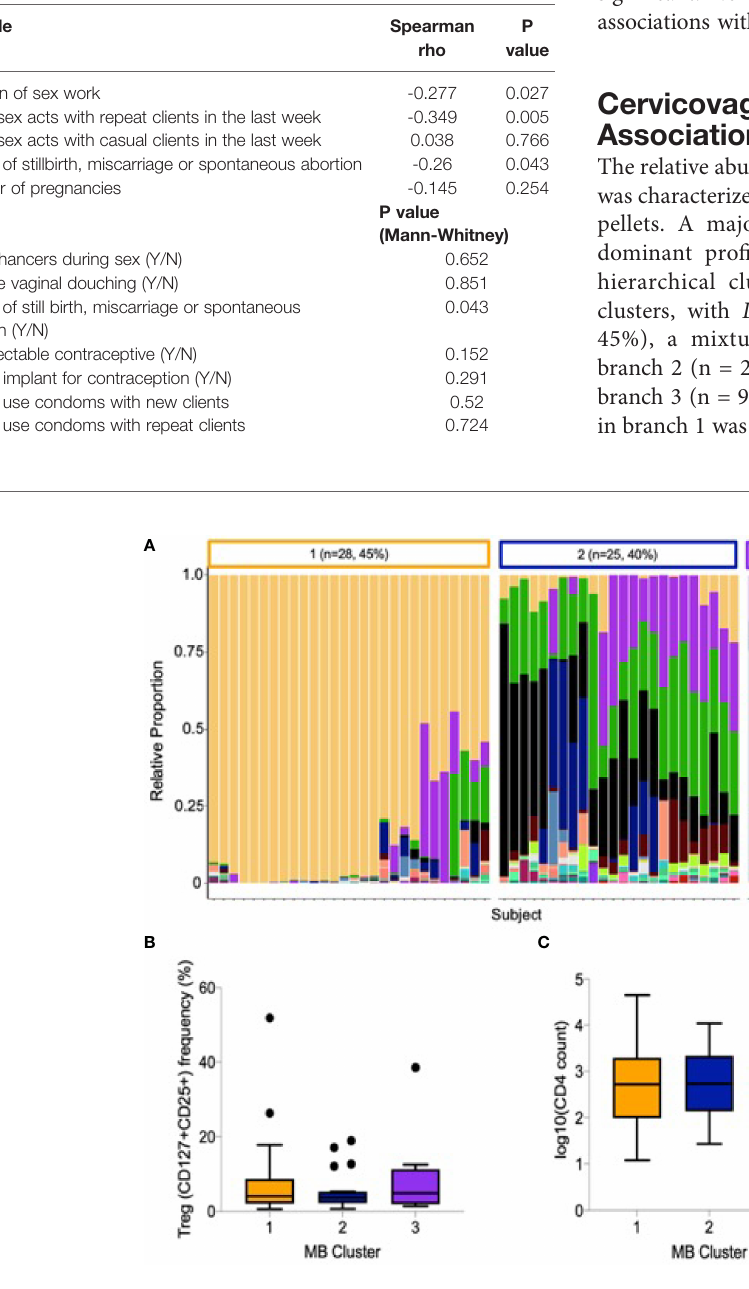
FIGURE 2 | Cervicovaginal microbial pro fi les amongst female sex workers from Nairobi, Kenya (n = 62). (A) Unsupervised clustering of relative abundance of microbial communities summarized by taxa with 45% being Lactobacillus dominant, 40% a mixture Sneathia, Prevotella , and Gardnerella and 15% predominantly Gardnerella spp . (B) Association of microbial clusters 1, 2 and 3 with Treg frequency and (C) absolute CD4 T cell count.